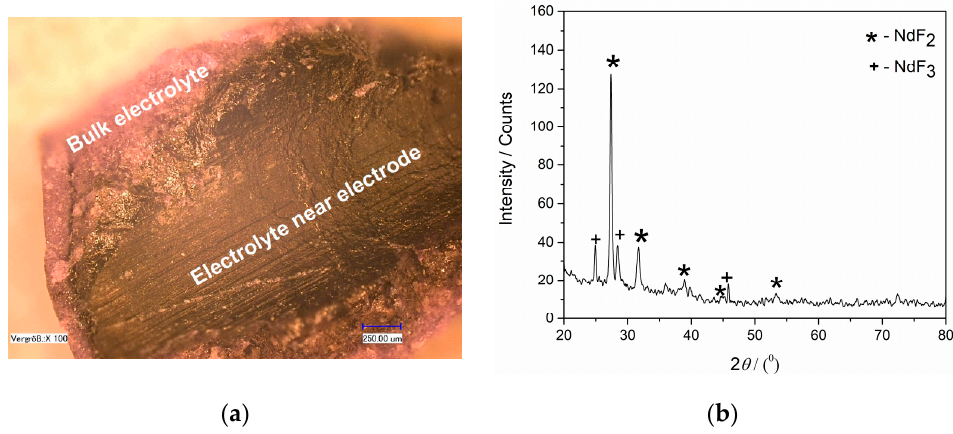
Figure 11. ( a ) Optical micrographs of the electrolyte pealed of the Mo electrode after 3600 s deposition at − 0.90 V in molten NdF 3 –LiF–Nd 2 O 3 electrolyte, at 1323 K; ( b ) XRD spectra of the electrolyte surface which was next to the electrode surface.